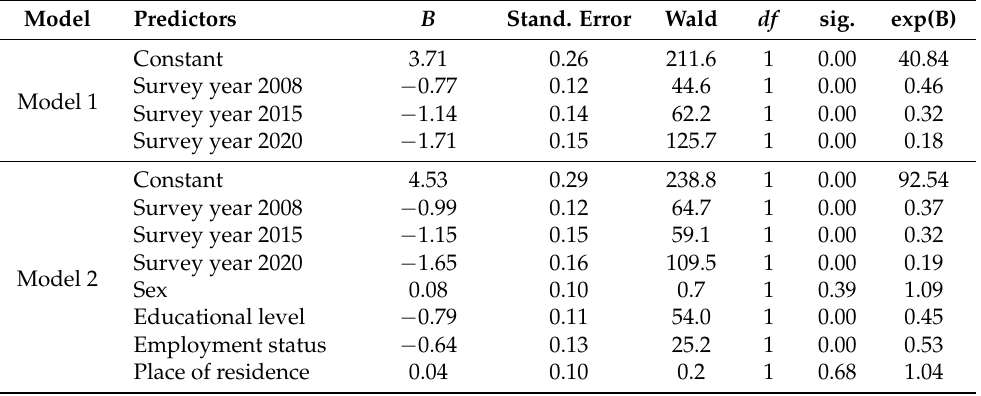
Table 5. Regression parameters for predictors of daily smoking (young adults between 2004 and 2020).